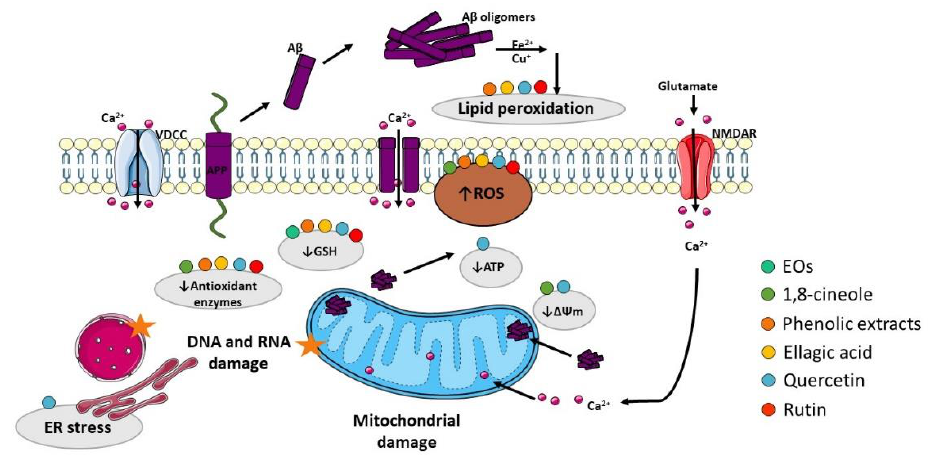
Figure 4. Effect of compounds obtained from E. globulus leaves in oxidative stress and mitochondrial damage in AD. A β oligomers can insert the plasma membrane originating pores by which Ca 2+ pass into the cytoplasm. A β can also interact with metal ions (Fe 2+ and Cu + ) to generate reactive oxygen species (ROS), which cause membrane lipid peroxidation. As consequence, the membrane turns depolarized, and voltage-dependent Ca 2+ channels (VDCC) and glutamate receptor-associated channels (in particular NMDAR, N-methyl-D-aspartate receptor) open increasing cytoplasmic Ca 2+ content. Additionally, A β overproduction can cause mitochondrial damage, which culminates in ROS accumulation and ATP depletion that can impair axonal transport consequently originating abnormal mitochondrial dynamics and promoting neurotransmission deficits. ATP depletion can also lead to ionic alterations in the cytosol due to dysfunction of ATP-dependent ion channels. Moreover, ROS accumulation affects the mitochondrial permeability transition pore (MPTP), which further potentiates mitochondrial damage due to Ca 2+ overload and inhibition of the electron transport chain. ROS increase also promotes damage to proteins, namely DNA and RNA.